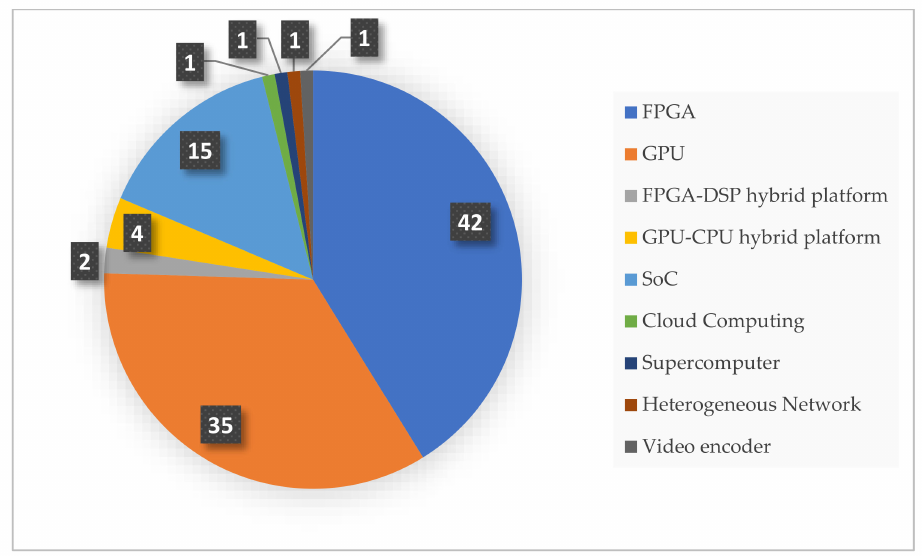
Figure 5. Statistics showing the number of the adopted hardware platforms for HSI